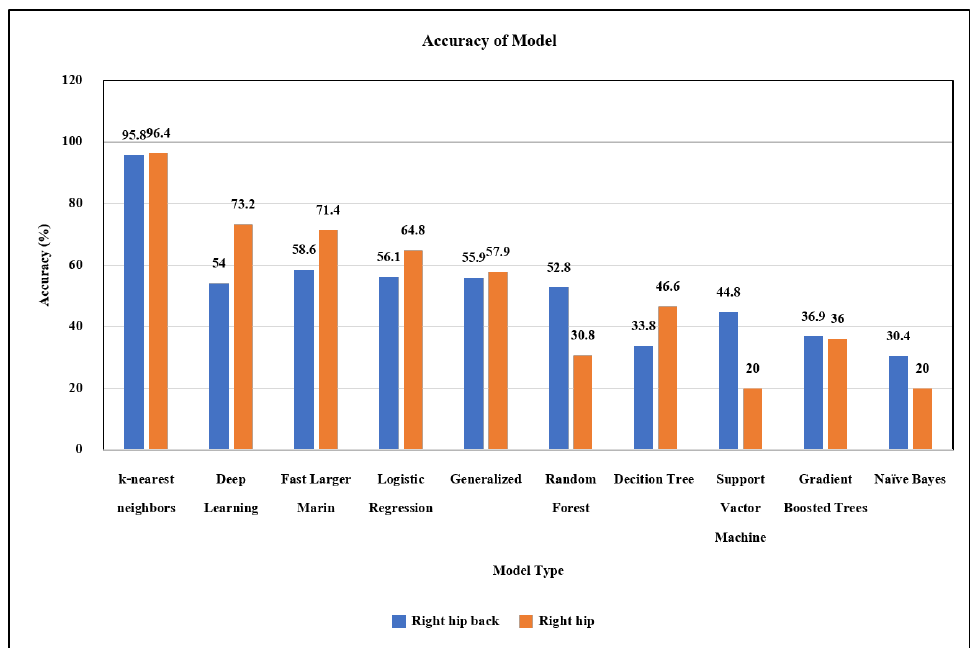
Figure 2. Comparison of classifiers with two alternative positions of the wearable